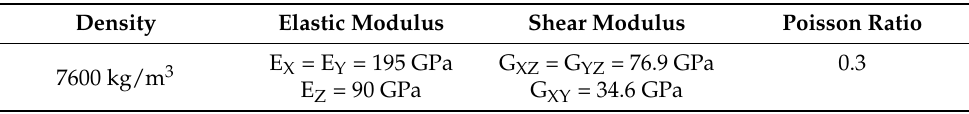
Table 2. Stator core material parameters.